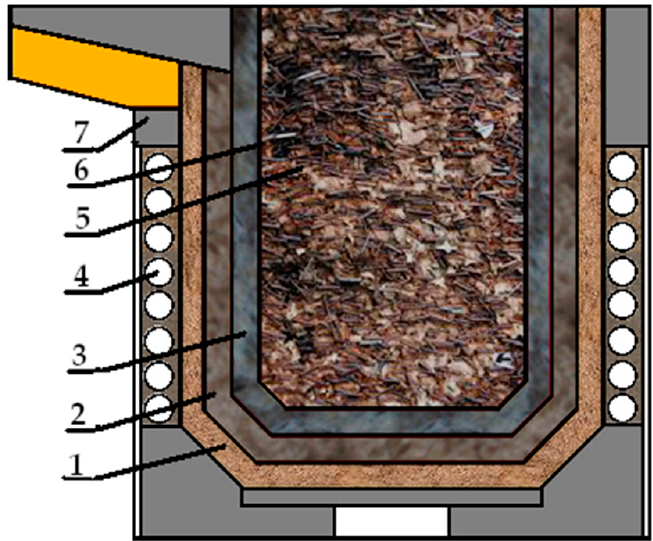
Figure 3. Scheme of the furnace indicating the zones of the lining: 1—the bulk layer; 2—the semi-welded layer; 3—the sintered layer; 4—the furnace inductor; 5—the metal load; 6—the polished layer; 7—the furnace body.